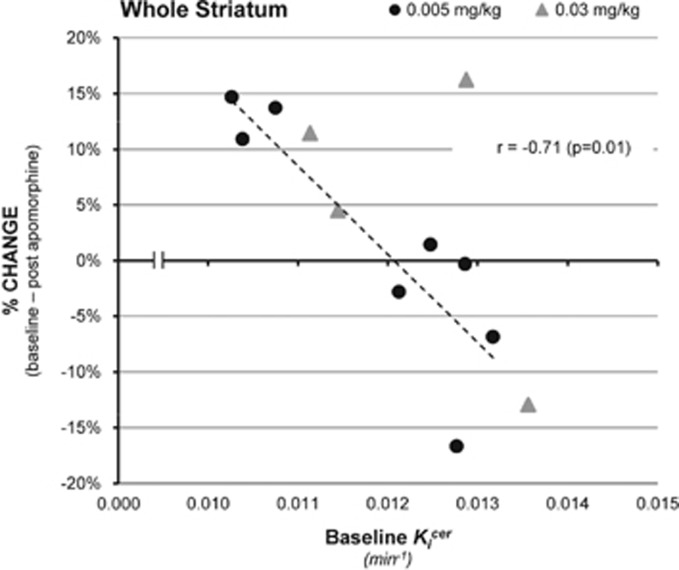
Correlation between baseline Kicer and percentage change in Kicer under apomorphine challenge (triangle=0.03 mg kg−1 dose, circle=0.005 mg kg−1 dose), indicating that the effect of apomorphine on dopamine synthesis capacity depends on baseline dopamine synthesis capacity.